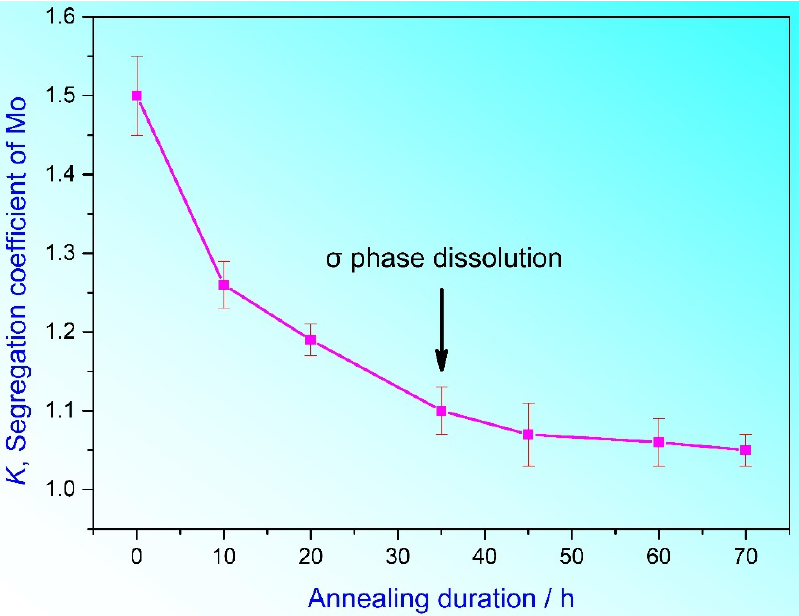
Figure 2. The relationship between the segregation coefficient of Mo element ( K ) and the annealing duration.